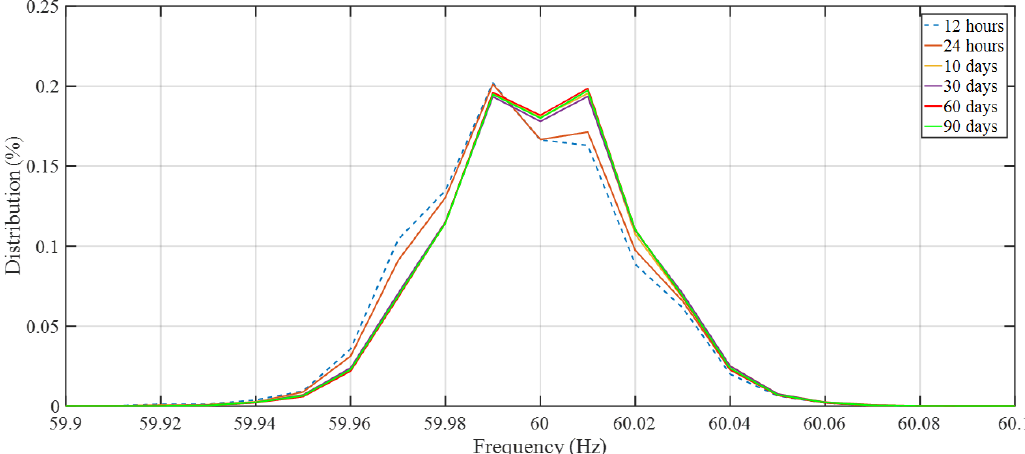
Figure 3. Frequency distribution according to analysis time.